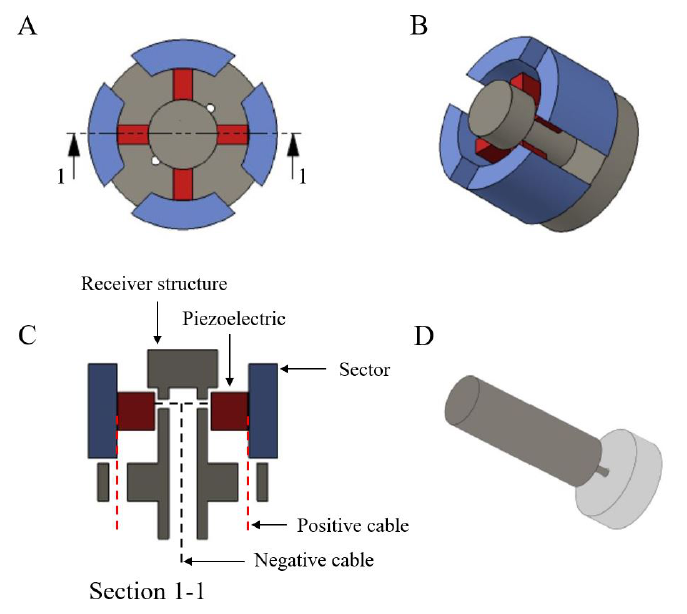
Figure 1. Schematic view of the two main components of the transluminal probe: ( A ) top view of the sensor showing the sectorized-anglewise ring (in blue), and the piezoelectric elements (in red); ( B ) isometric view of the assembled sensor; ( C ) sagittal cross-section of the sensor showing the wiring and supporting structure; ( D ) isometric view of the emitter disk (in light gray) and the electromechanical actuator (in dark